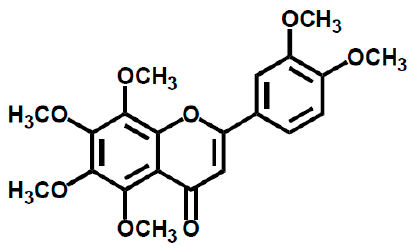
Figure 1. Chemical structure of nobiletin.